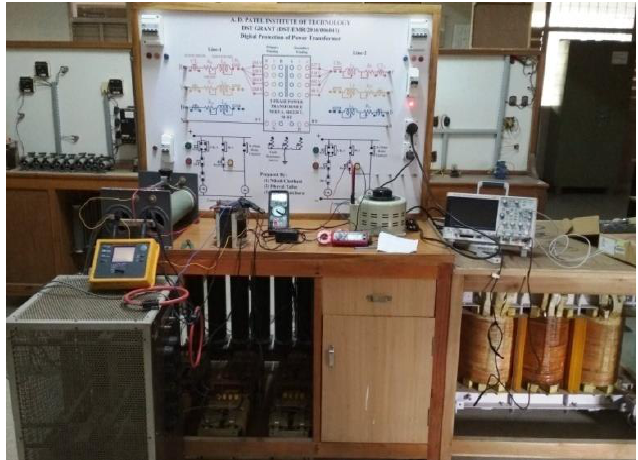
Fig. 5. Developed laboratory